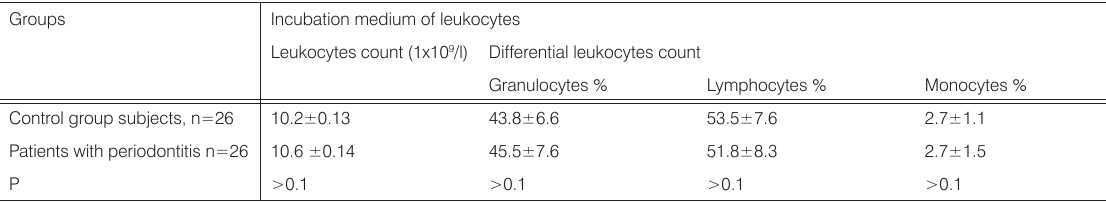
Table 1. Leukocyte count and percentage distribution in incubation medium Groups